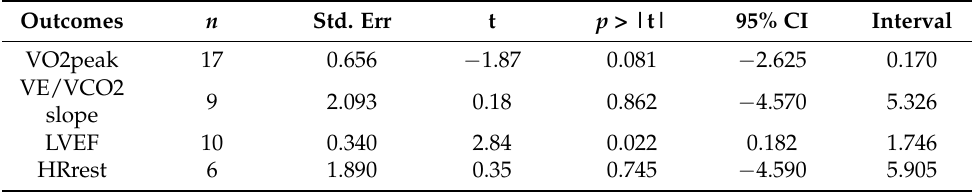
Table 4. Egger’s test of the included